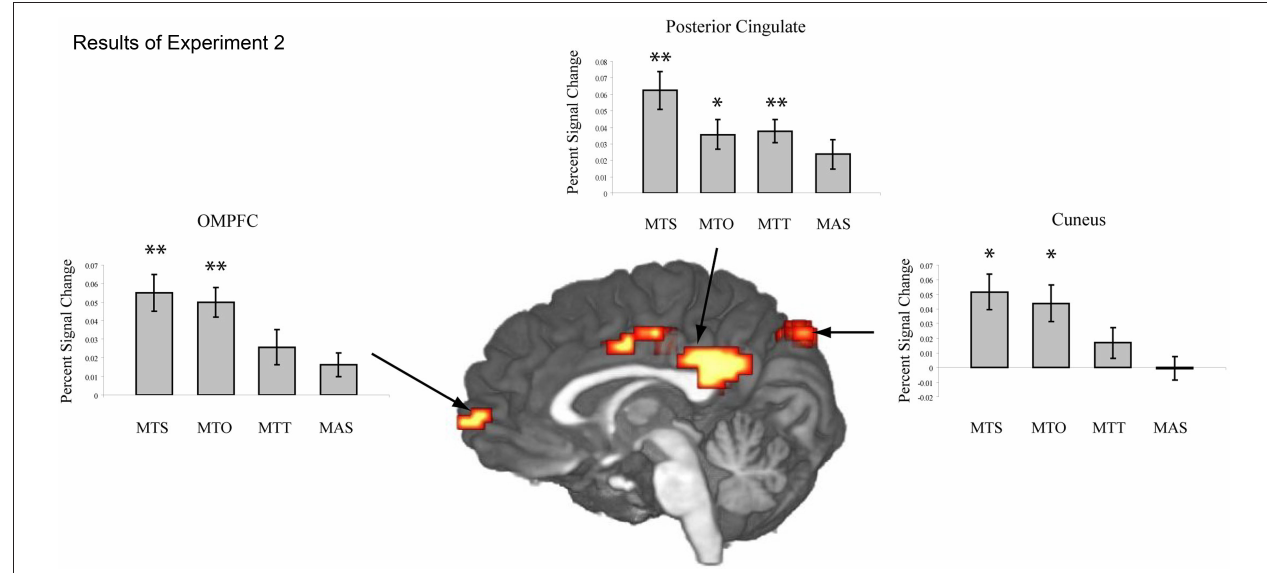
sentence conditions presented in Experiment 2: MTS = movement toward self, MTO = movement toward other, MTT = movement toward thing, MAS = movement away from self. Activation in the cortical midline structures is significant for both MTS and MTO sentences, but not for MTT or MAS sentences. A single asterisk indicates a difference significant at the 0.05 level, and two asterisks indicate a difference significant at the 0.01